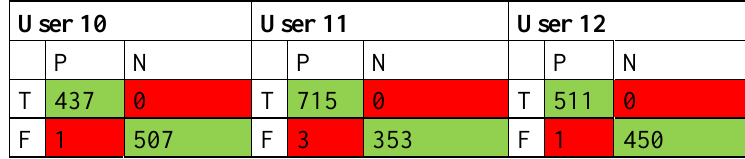
Table 17. SCR confusion matrix for annoying sounds